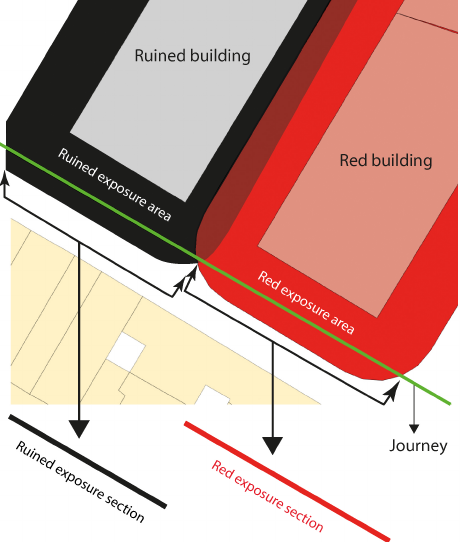
Figure 6. Exposure sections produced by the Intersect geoprocess- ing tool between journeys (green lines) and exposure areas around fragile buildings (ruined and